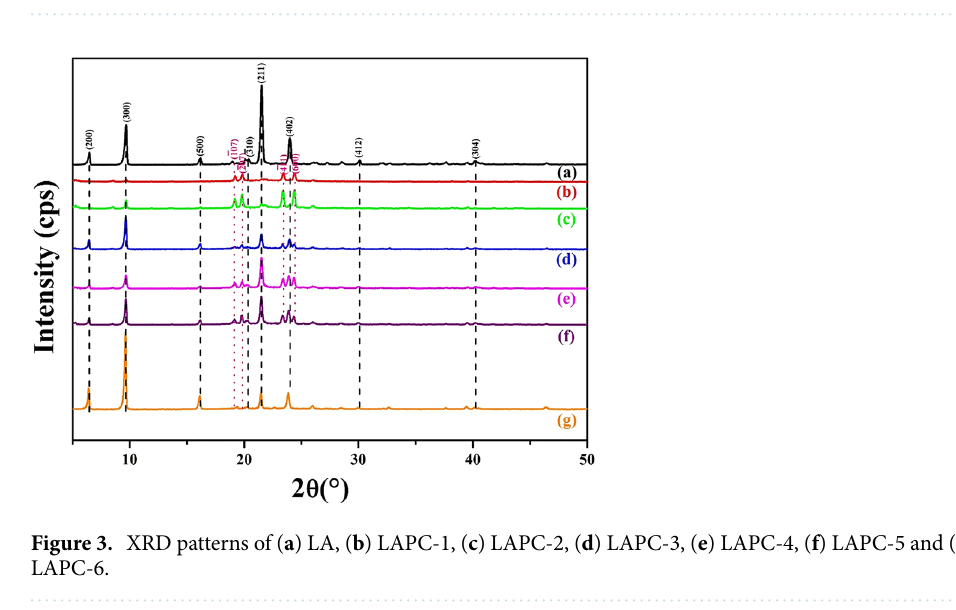
Figure 2. FT-IR spectra of ( a ) LA, ( b ) LAPC-1, ( c ) LAPC-2, ( d ) LAPC-3, ( e ) LAPC-4, ( f ) LAPC-5 and ( g ) LAPC-6.